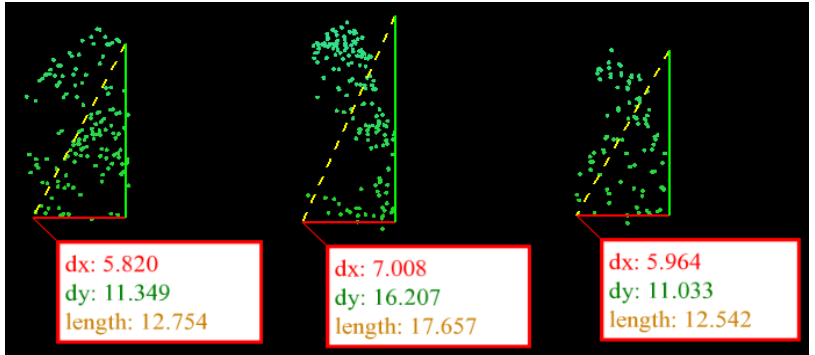
Figure 14. Three well-extracted trees with small canopy sizes.